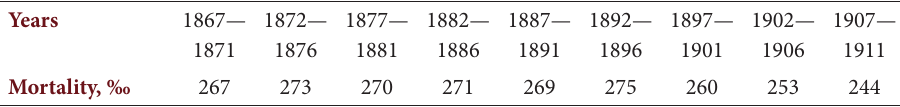
Table 7. Infant mortality in European Russia in 1867-1911 per 1000 births, ‰